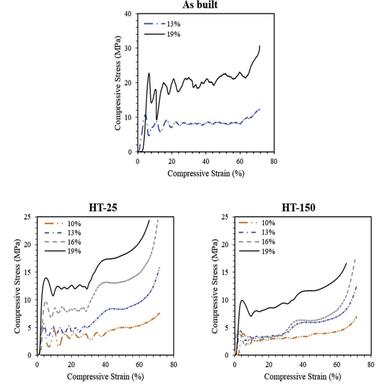
Compressive stress-strain curves of the testing of the IWP TPMS in the as-built condition, and after the heat treatment at 25 and 150 �C.